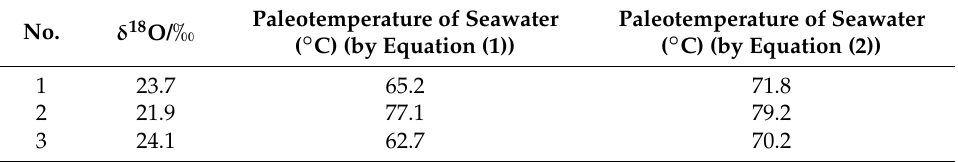
Table 4. Oxygen isotope of the Upper Ordovician-Lower Silurian shale and sedimentary environment temperature calculated by empirical